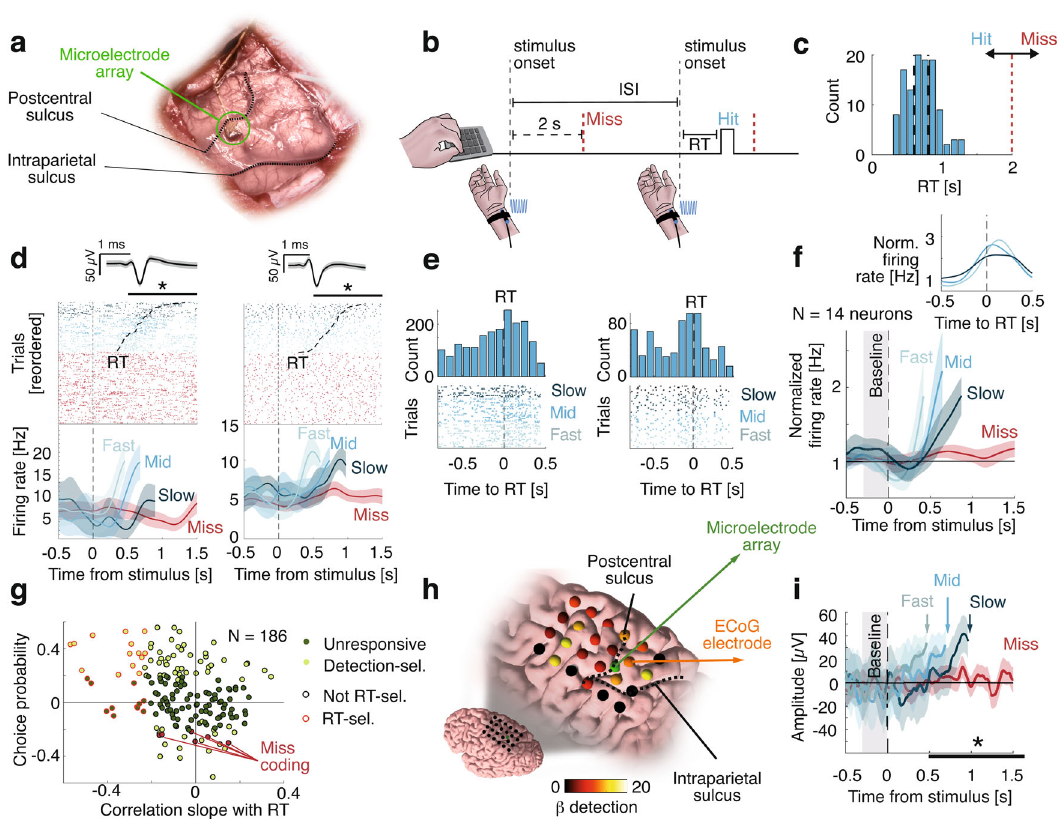
Fig. 1 Neuronal correlates of detection in an immediate-response task (Experiment 1). a Intraoperative photo of the microelectrode array posterior to the postcentral sulcus and dorsal to the intraparietal sulcus. b The participant pressed a key as soon as they felt a stimulus. In this example, the fi rst stimulus is a miss (i.e., no key press within 2 s following stimulus onset) and the second stimulus is a hit (i.e., key press within 2 s following stimulus onset). ISI inter- stimulus interval. c Distribution of response times (RT) and response deadline for a trial to be considered as a hit (red vertical dashed line). The y axis represents the number of trials. d Example detection- and RT-selective neurons. Top: raster plot time-locked to stimulus onset with spike waveform and shaded standard deviation above. Hits were reordered according to RT (black dashed trace). Bottom: average fi ring rate for three terciles of RT for hits and for misses. Statistics were performed on continuous RT data. Asterisks indicate statistical signi fi cance; left: detection-selective: p = 0.013 (Wilcoxon ranksum test), RT-selective: p < 0.001 (Spearman correlation); Right: detection-selective: p = 0.046, RT-selective: p = 0.0056 e Top: RT-aligned spike count histograms for neurons in d (50 ms bins). The y axis represents the number of trials. Bottom: corresponding raster plots. f Average fi ring rates for detection- and RT- responsive neurons, for three bins of RT for hits and for misses. Firing rates were normalized to a 0.3 s pre-stimulus baseline and time- locked to the stimulus onset. Inset: Corresponding average fi ring rates time-locked to the response. g Choice probability as a function of the correlation between the slope of the fi ring rate and the RT for all neurons with detection-selective neurons in light green, miss coding in red and other neuron in dark green. RT-selective neurons are circled with red. h ECoG grid with beta ( β ) coef fi cients for detection. Non-signi fi cant electrodes are in black. i Average ECoG amplitude, aligned to stimulus onset from one electrode posterior to the microelectrode array for three terciles of RT for hits and for misses. Asterisk indicates statistical signi fi cance; p < 0.001 (linear model). In all panels, misses are depicted in red and hits in blue, shaded areas represent 95%-CI, black horizontal bars represent the analysis window for